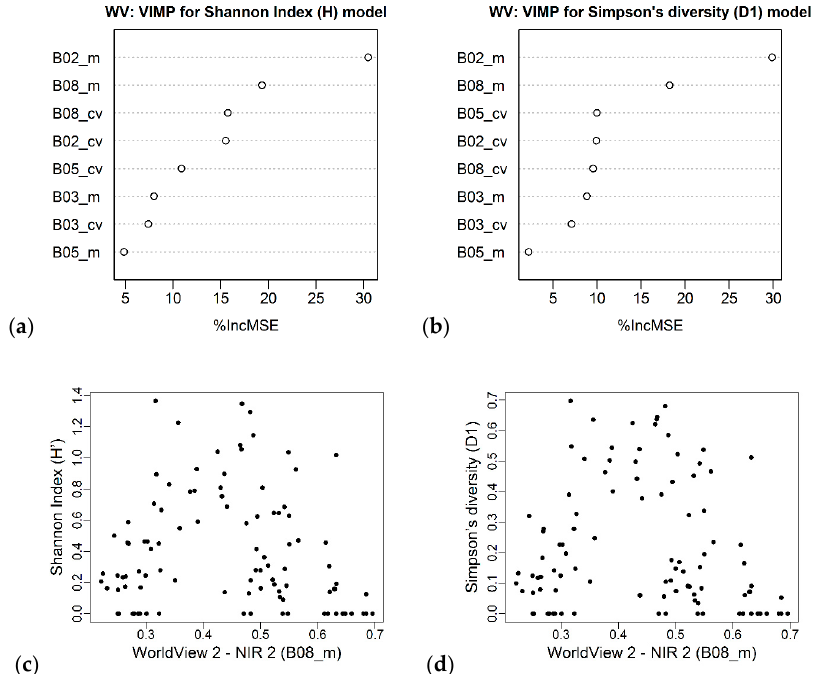
Figure 5. Importance of WorldView-2 bands using the percentage increase in mean squared prediction error (%IncMSE) for ( a ) Shannon’s (H’) and ( b ) Simpson’s diversity (D1) indices. Scatterplots of ( c ) Shannon’s ( H’ ) and ( d ) Simpson’s diversity ( D1 ) indices with the second NIR band (B08_m) of WorldView-2 are also presented.